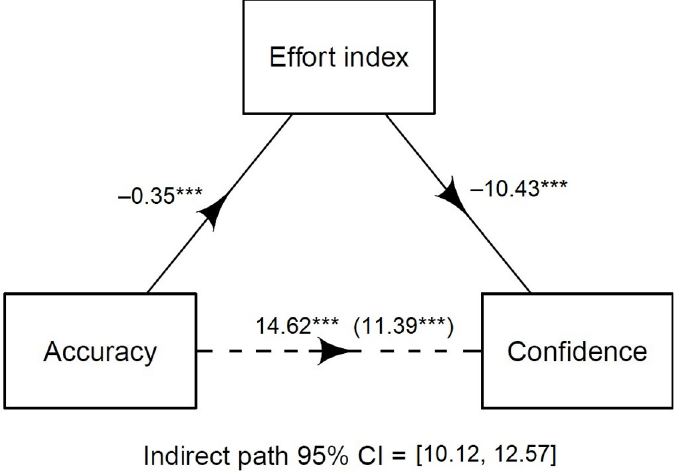
Fig 5. Mediation analysis between memory accuracy and confidence, with the retrieval-effort index as